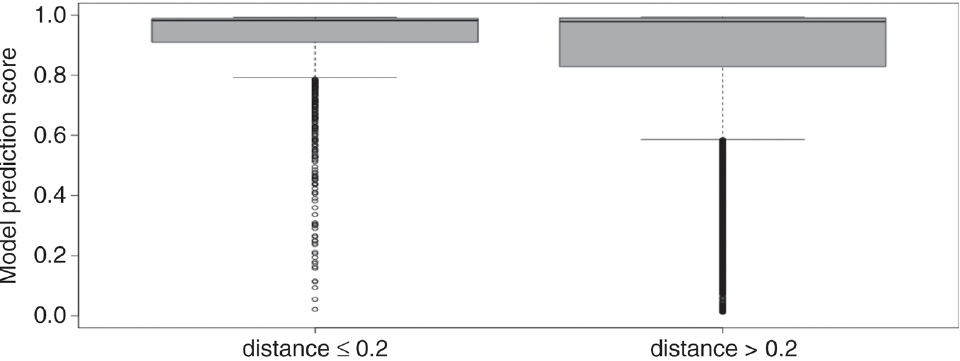
Figure 8: Model score distribution for 2139 miRBase hairpins with maximum 0.2 distance score to entries in MirGeneDB (left). Right part shows the model score distribution for 26,505 hairpins with distance values greater than 0.2 to Mir- GeneDB